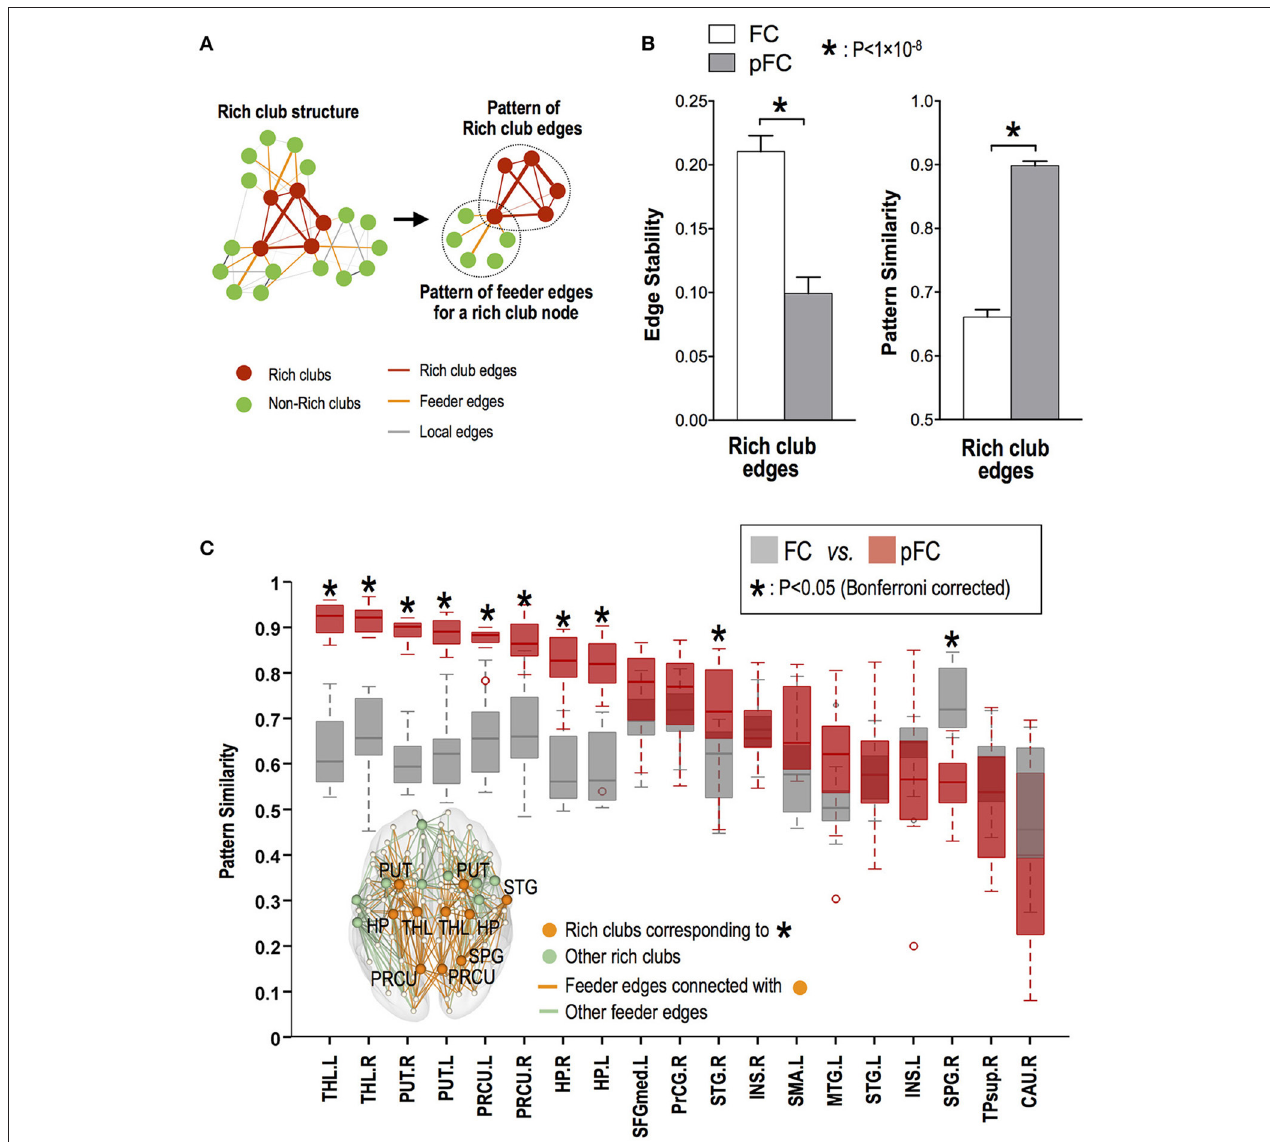
FIGURE 6 | Stability of multivariate edge involvement patterns for rich club and feeder edges. (A) Multivariate edge involvement pattern in a subnetwork composed of rich club edges and the pattern in a subnetwork composed of feeder edges for each rich club node. (B) Univariate edge stability (mean ICC) of functional connectivity and temporal similarity of multivariate edge involvement patterns for rich club edges. (C) Stability of feeder edge involvement patterns for a subnetwork of each rich club node, where star (*) indicates significant difference between pattern stability in FC and stability in pFC. THL, thalamus; PUT, putamen; PRCU, precuneus; HP, hippocampus; STG, superior temporal gyrus; SPG, superior parietal gyrus; L, left; R, right.